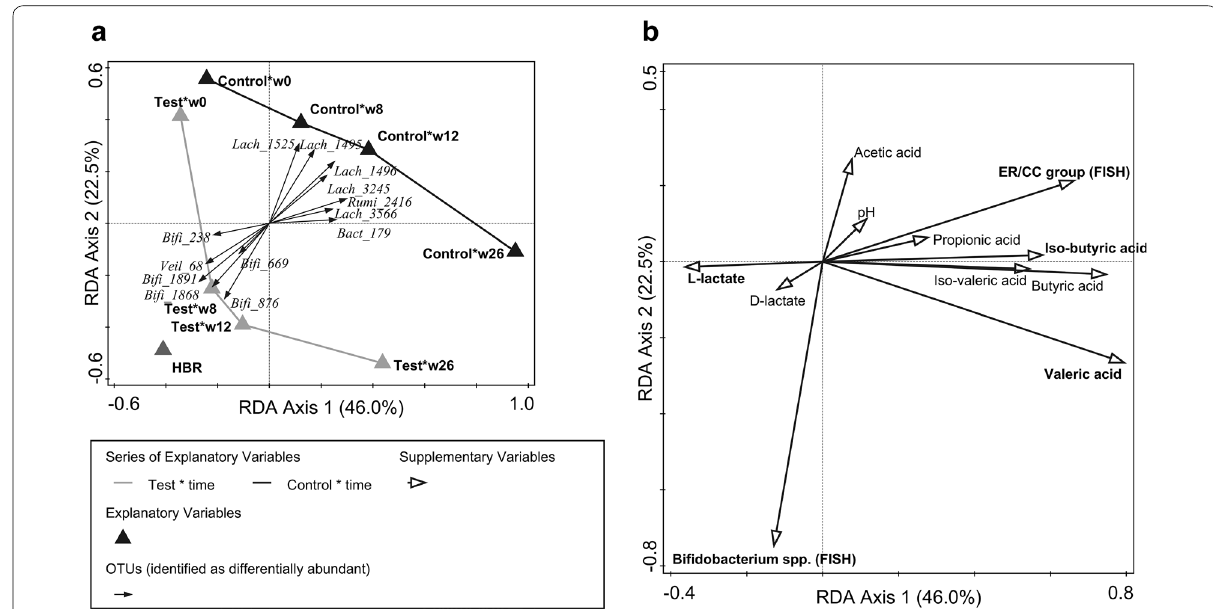
Fig. 6 RDA plot of faecal microbiota composition based on treatment by time interaction and the HBR reference group (age‑matched to week 8) as explanatory variables ( a ). OTUs that were identified as differentially abundant between test and control are plotted as biplot arrows in the RDA plot on the left. The same RDA plot is shown on the right ( b ), but then supplemented with faecal pH, FISH counts and levels of SCFA and lactic acids as correlation biplot. Variables that were significantly different between test and control are shown in bold. Taxa names are given at the OTU level with unique (but arbitrary) numbers as identifiers and the family level (“_f_”): Bact bacteroidaceae, Bifi bifidobacteriaceae, Lach lachnospiraceae,